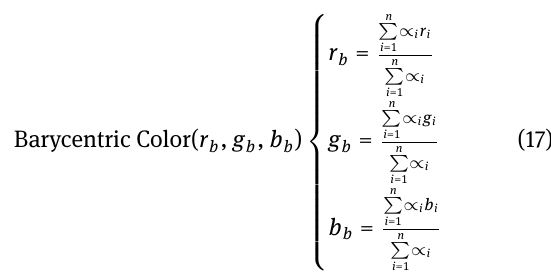
Figure 11: Proposed color scale in [38] by B. Weninger.